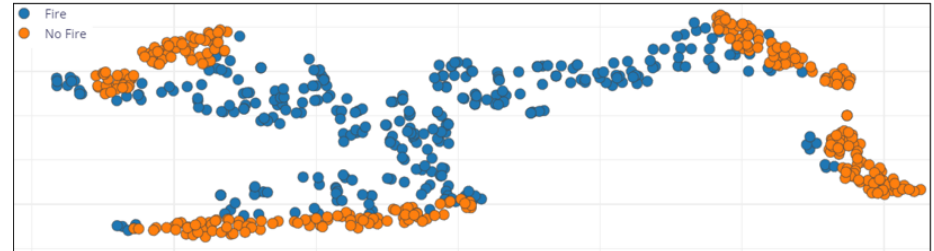
Figure 4. Exploring training/testing dataset (64